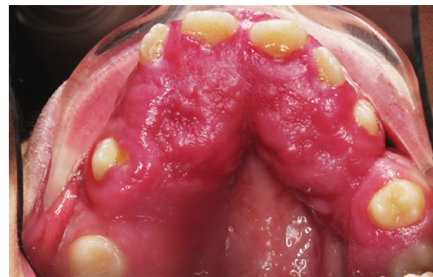
Figure 5: Upper occlusal view.